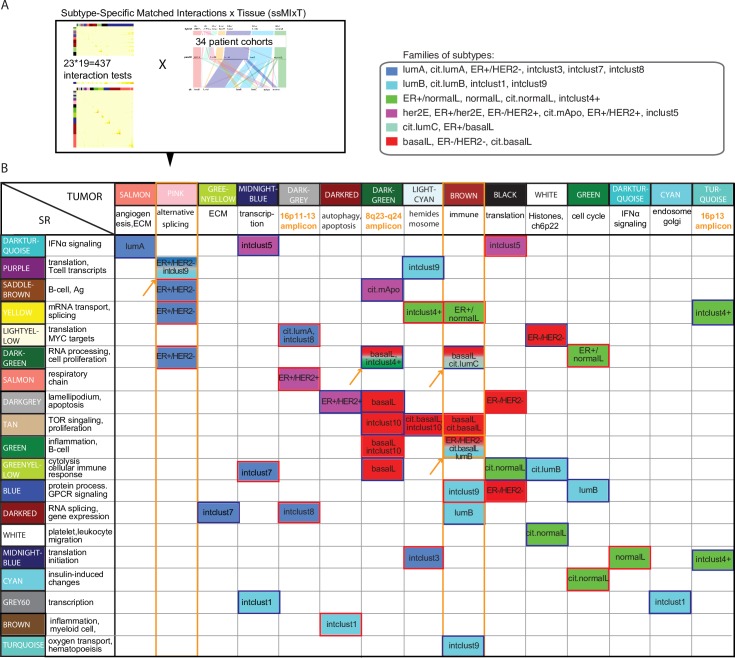
Subtype-Specific Matched Interactions across Tissue (ssMIxT).(A) Schematic of ssMIxT analysis (B) Significant associations between modules in SR and tumor from BC patients by subtype (MIxT statistic, p-value < 0.005). SR and tumor modules with top pathway enrichment keywords are presented in rows and columns, respectively. Subtype(s) in which the significant associations are found are indicated in the table. Blue and red borders correspond to negative and positive correlations between ranksums, respectively. Findings discussed in the text are highlighted in orange.